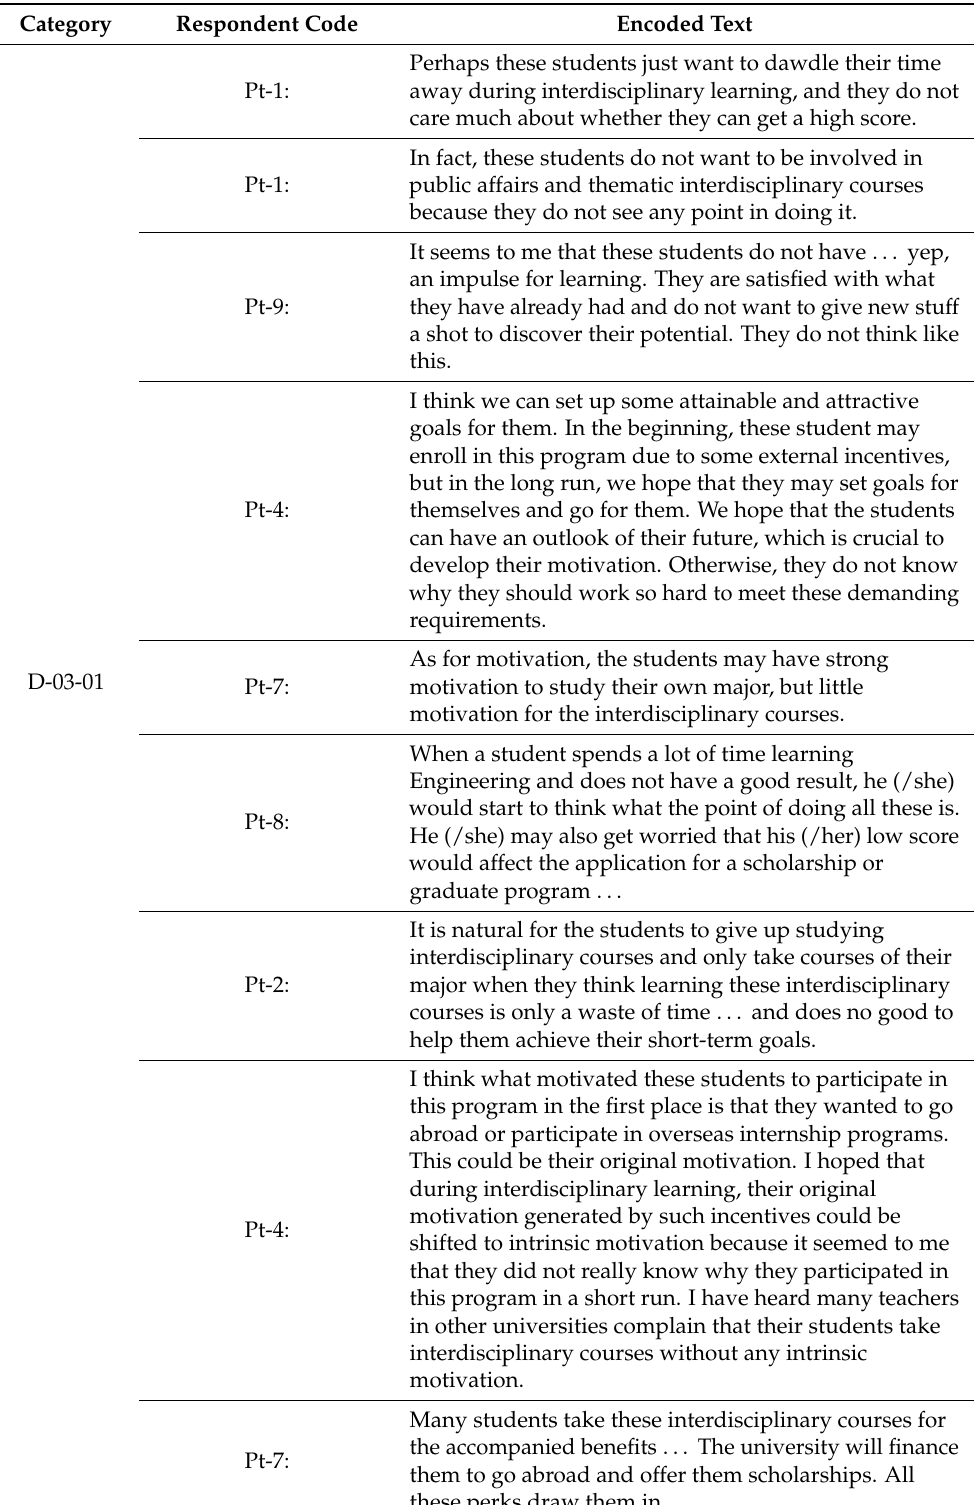
Table A4. Coding of D-03 Student